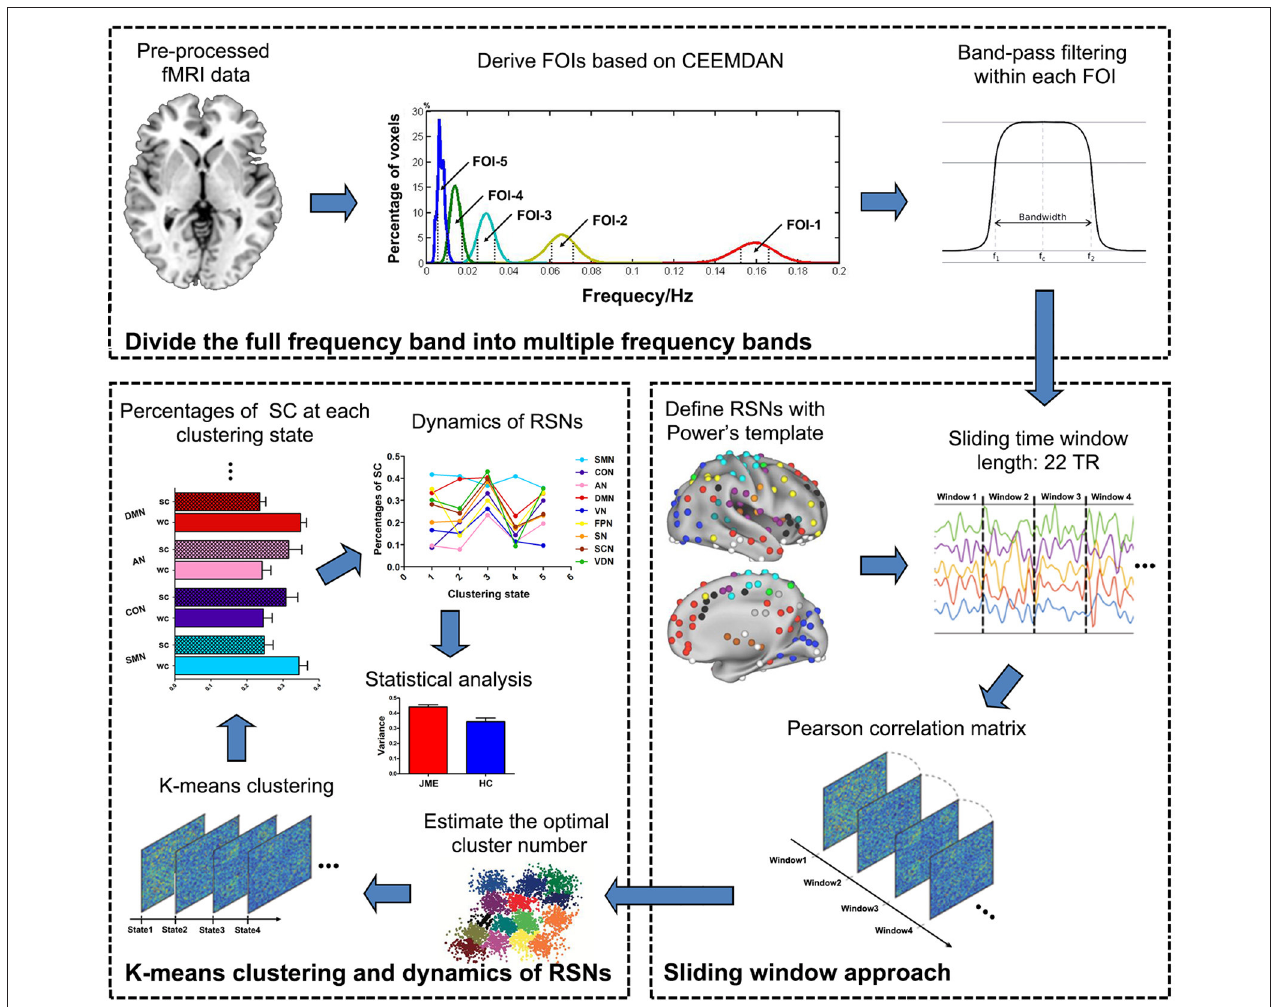
FIGURE 1 | Schematic representation of the steps in frequency-dependent dynamic FC. The analysis includes three main steps as follows: (1) five FOI bands were derived with CEEMDAN method and the preprocessed resting-state fMRI data were further filtered at each FOI band; (2) the sliding windows approach was used to identify 168 time-dependent FC matrices for each participant; (3) the k-means clustering was applied to estimate reoccurring states and the dynamics of RSNs was calculated across different